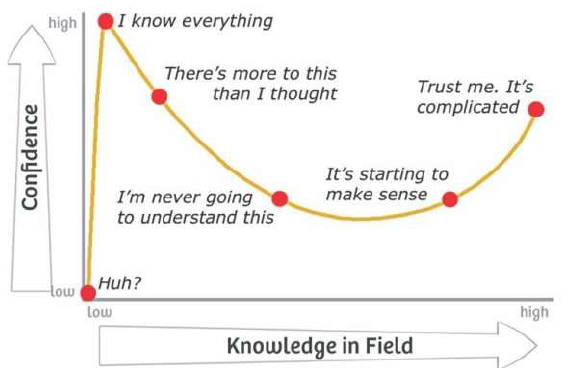
Figure 2. The Dunning–Kruger effect [44]. Reproduced with permission from Stanford Brown, retrieved from https://stanfordbrown.com.au/finance-101-the-dunning-kruger-effect/.